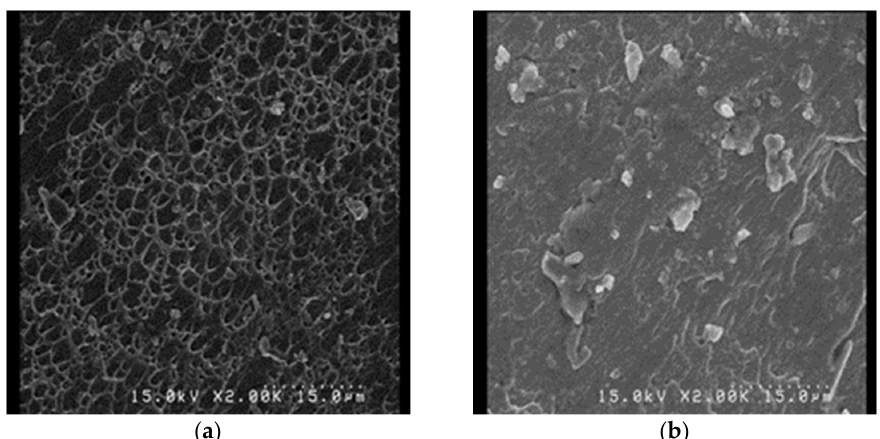
Figure 5. Typical fracture surface according to ductile and brittle. ( a )Ductile fracture. ( b )Brittle fracture.